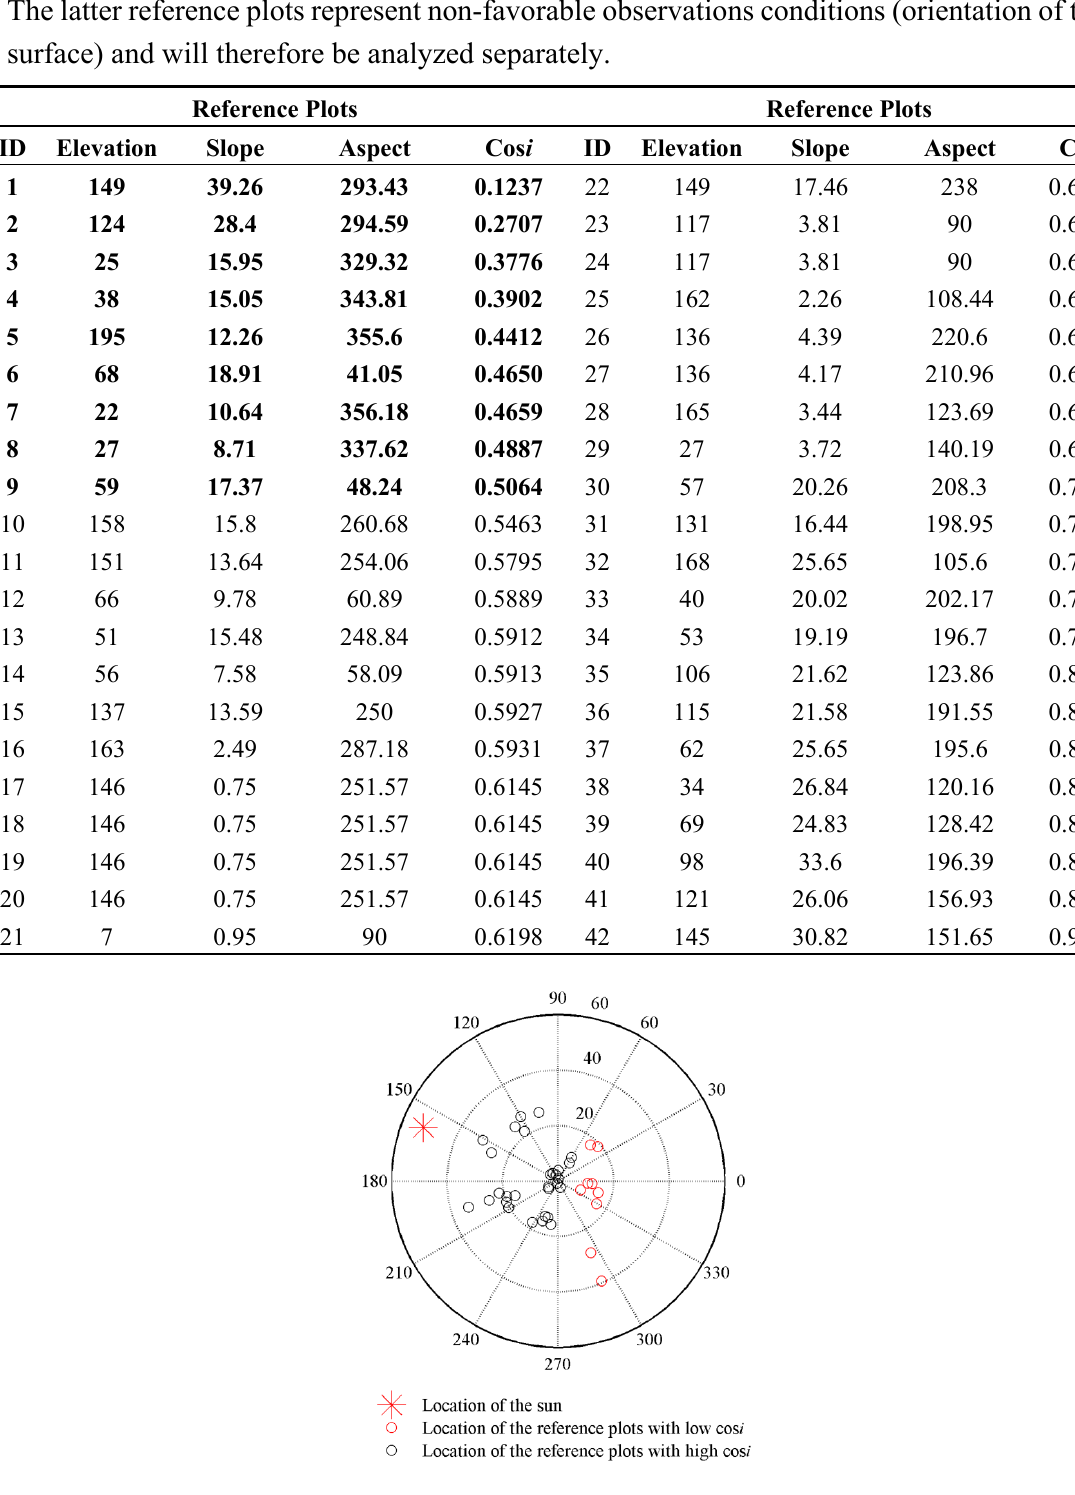
Figure 2. Location relationship between the reference plots and the